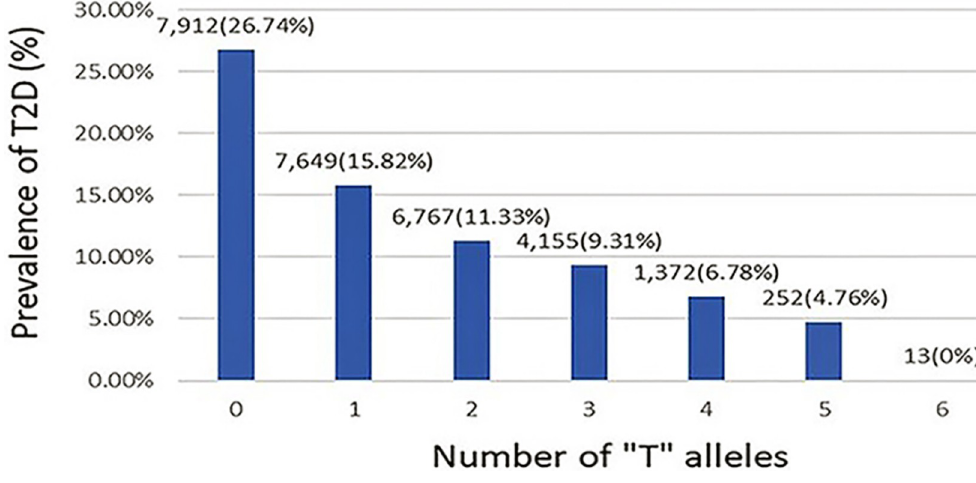
Fig 5. Joint effect size for the prevalence of T2D at rs1260326 ( GCKR ), rs560887 ( G6PC2 ), and rs13266634 ( SLC30A8 ). The label above each bar provides the number of individuals (% prevalence of T2D). At each SNP, the T allele is the allele associated with protection against